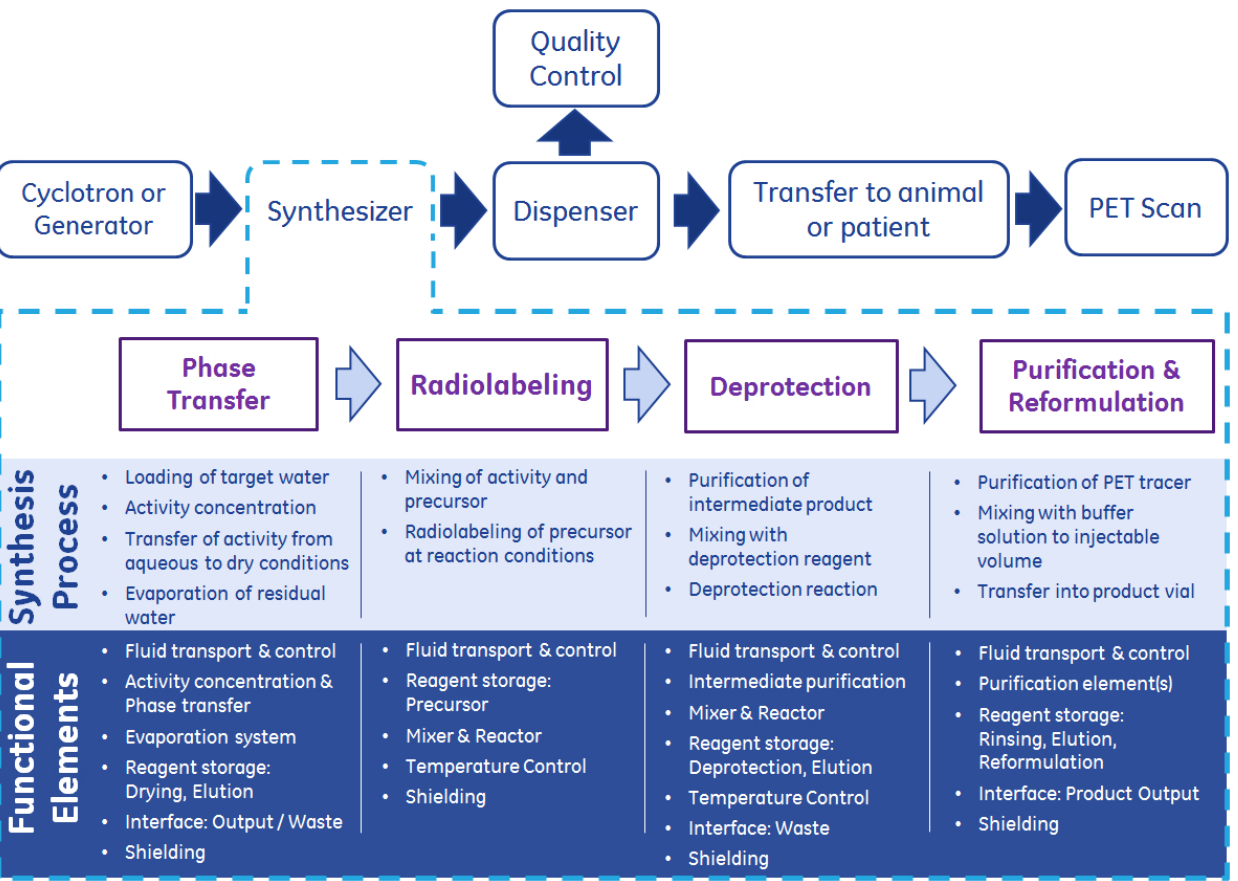
Figure 1. PET tracer production and synthesis workflow and resulting functional elements to be integrated into a microfluidic synthesis system. Synthesizer process description based on [ 18 F]FDG synthesis, several functional elements may not be required for the synthesis of other PET